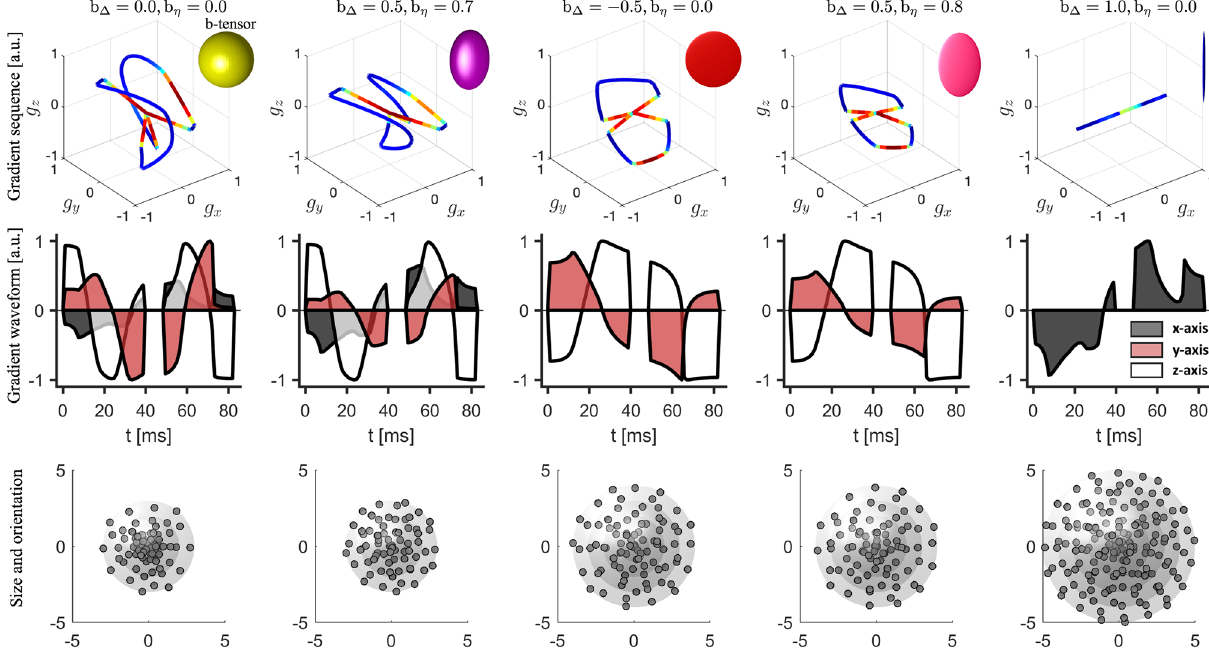
Figure 2. Illustration of the QTE sequences used to acquire the in vivo dMRI data. The plots in the first row show the 3-dimensional gradients and the shape of the corresponding b-tensors. The shape of b-tensors are determined by two parameters b (cid:31) and b η displayed on top of the plots. The curves are color coded by the slew rate, i.e. the rate of change of gradient sequences. The plots with different colors in the second row illustrate the gradient waveforms along the x-, y-, z-axises, respectively. In row three, the magnitude and orientation of a point on the spheres correspond to the trace, i.e. b-value, and an eigenvector of a b-tensor. The maximum 2 b-values for the five types of b-tensors are equal to 3, 3, 4, 4, 5 ms / µ m , respectively. The spherical or planar shapes in the top-right corner of figures in the top row represent the “shape” of b-tensors instead of the diffusion tensors as in Fig. the FA , the micro-FA ( µ FA ) and their STD values. The red and yellow circles in Fig. 3a point out two white- matter regions with relative lower FA values but with uniform µ FA measures compared to other white-matter regions. The STD map in Fig. 3d shows that µ FA is more reliable in white-matter. The second row shows that µ FA slow is higher than µ FA fast especially in gray matter. It was shown in 11 that extra-axonal water may have slower diffusivity than the intra-axonal water. Thus, extra-axonal water may be also related to higher µ FA . Fig- ure 3f,h show that µ FA slow has lower STD values than µ FA mfast especially in white matter. The third row shows the SK , the micro-SK, µ SK and their STD maps. The white-matter region in the yellow circle has more negative SK values than the region corresponding to the red circle, though the FA in the yellow circle is relative higher. Thus, the diffusion tensors in the yellow-circle region are more prolate and anisotropic than those from the red- circle regions. The difference in FA and SK between the two regions may be related to the number of crossing- fibers 12,13 , the fiber dispersion 14 and/or the angle between crossing fibers 15 , which needs to be further examined. The STD of SK in Fig. 3j is relatively high in white-matter, especially in regions with crossing fibers. The very high µ SK values in the boundary between white/gray matter and the cerebrospinal fluid (CSF) in Fig. 3k are related to high STD values shown in Fig. 3l. It indicates that the µ SK in these regions are sensitive to measurement noise, which may be related to the underlying partial volume effects, i.e. both CSF and white/gray matter are contained in the underlying voxel. Parameter uncertainty is inflated in a band toward the posterior of the brain as shown in Fig. 3b,f,h,j. This is likely due to poor fat saturation causing a mixture of fat and water signals at this location, as previously described by 9 . Accuracy and precision of diffusion indices. To examine the reliability of the estimated indices, the 513 b-tensors were applied to simulate dMRI signals for the three DTDs shown in Fig. 1 with additive Gaussian ν with B representing one of the 513 e − B : D noise. The dMRI signals were computed by sampling s ( B ) = � � ρ + b-tensors and ν representing the zero-mean Gaussian noise. For a fixed standard deviation of Gaussian noise, the 513 dimensional dMRI signals were sampled 5000 times. Then, the same estimation methods as applied in the in vivo experiment were applied to estimate the µ FA fast , µ FA slow and µ SK measures. To further examine the accuracy and precision of the indices for different DTD functions, the experimental procedure was applied to the DTD function shown in Fig. 1c with varying volume fraction of anisotropic components and the signal to noise ratio (SNR), i.e. the ratio between the mean signal and the standard deviation of noise, being fixed at SNR=30 similar to the SNR values of the in vivo data.